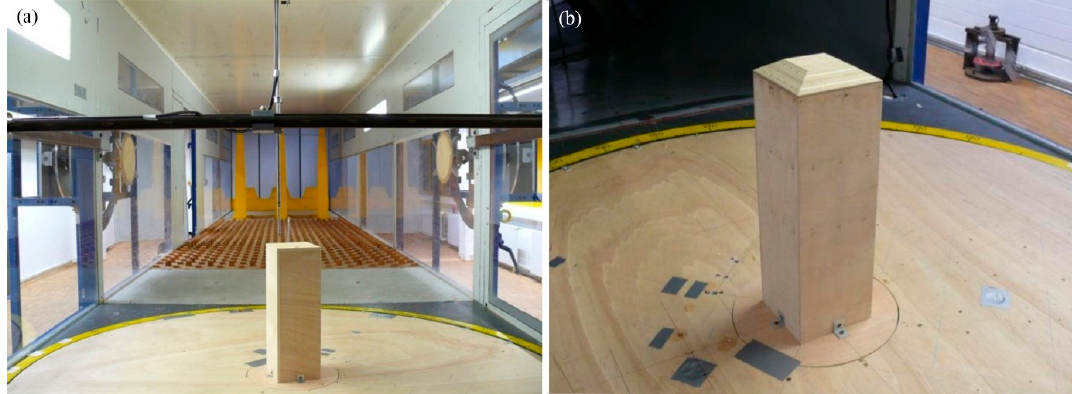
Figure 2. The two building models mounted in the wind tunnel, ( a ) flat roof and ( b ) deck roof.